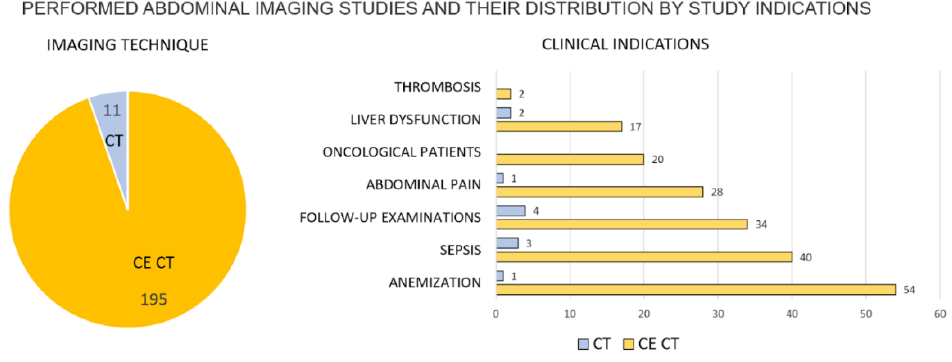
Figure 1. Left : Contrast Enhanced Computed Tomography—CE CT (and CTs) are 94.7% (5.3%) of all the acquired CTs. Right : study indications for each imaging modality show that anemization is the study indication for which most CE CTs were acquired, while CTs were mostly used for follow-ups. Sixteen patients were found to have pulmonary embolism at chest CT performed before or during abdominal examinations. Embolism was not associated with any abdominal finding ( p > 0.05).